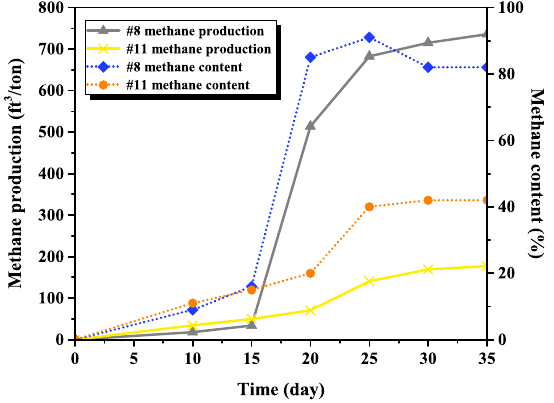
Figure 1. Methane content and production for two bioconverted